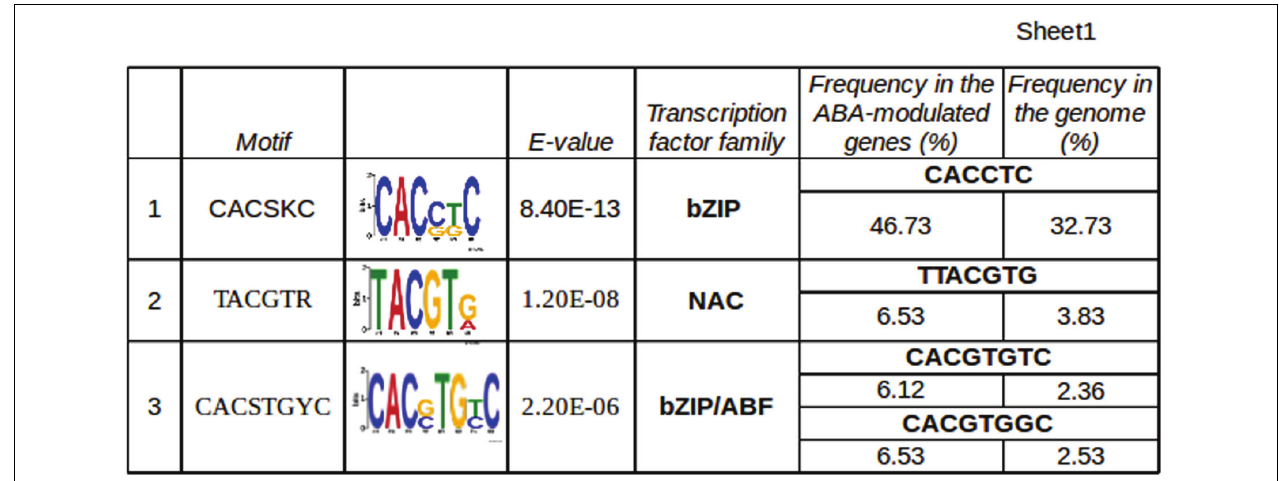
FIGURE 6 | In silico promoter analysis of the genes modulated at both 20 and 44 h. The 1 kb promoter regions have been analyzed in DREME (Bailey, 2011) and motif enrichment has been calculated using the whole genome promoters as reference. The three most enriched motifs and the transcription factor families they are likely recognized by, are reported. A refined search of the most enriched exact sequence motifs has been performed using Patmatch (Yan et al., 2005) and the corresponding frequencies are reported in the last two